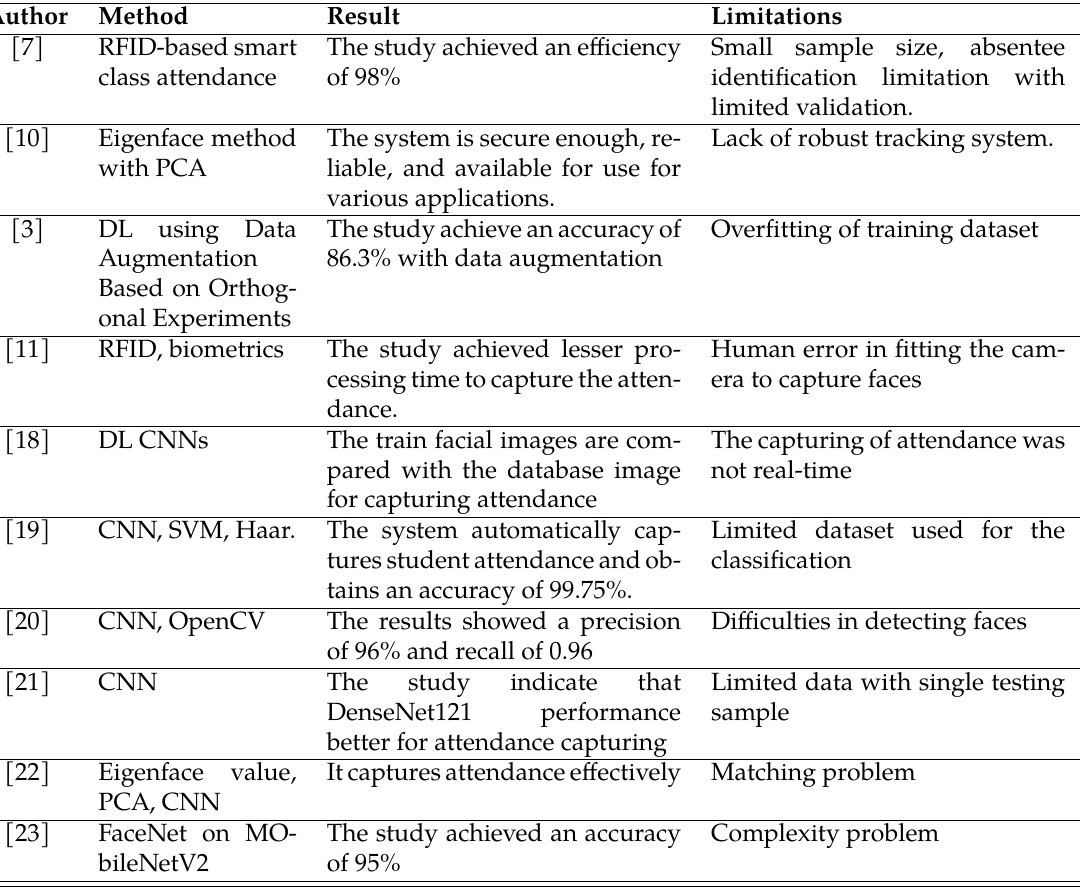
Table 1: Summary of Literature